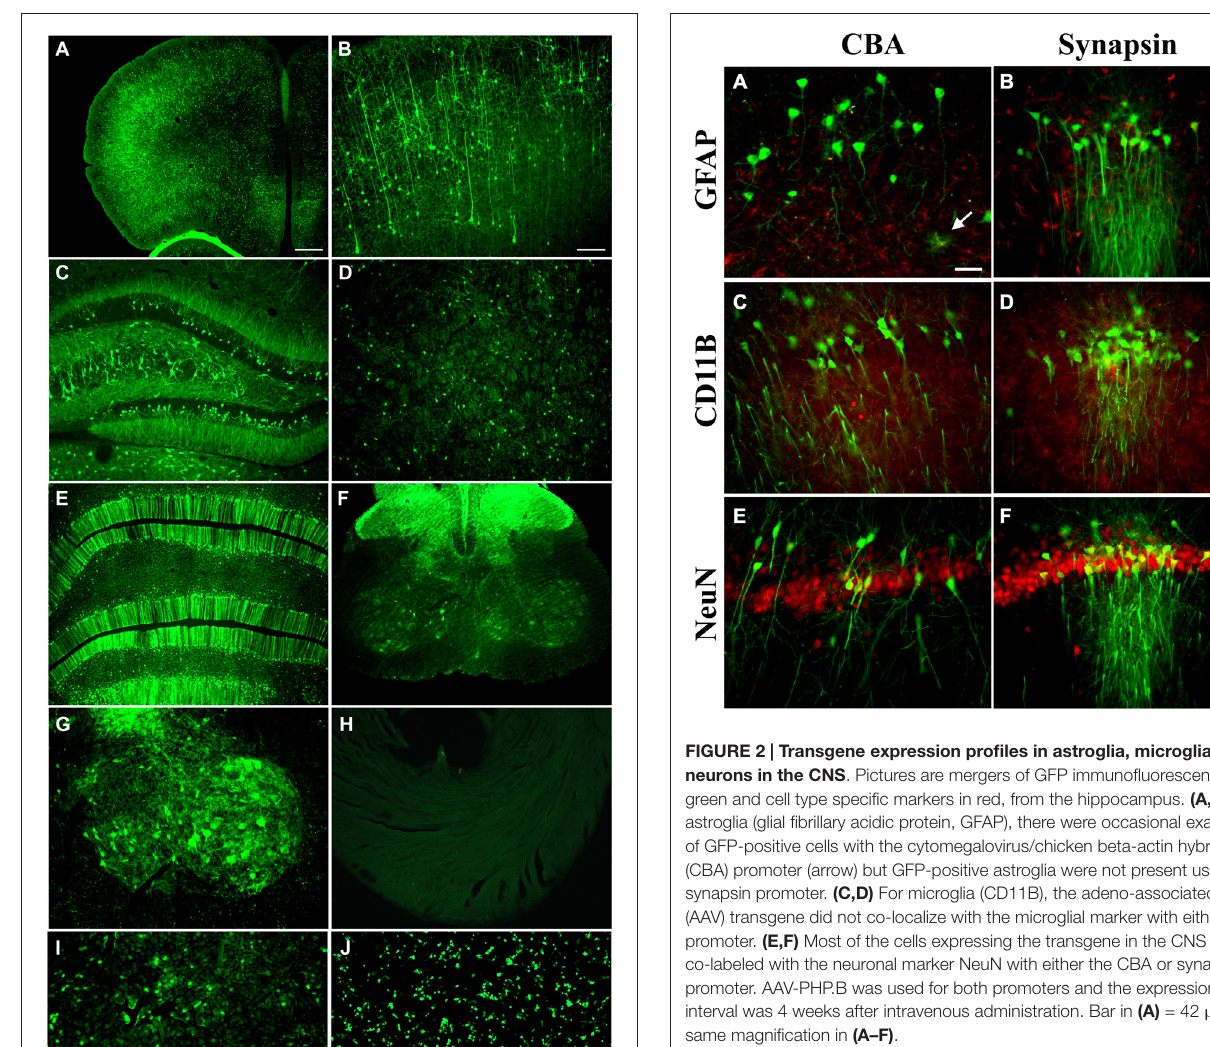
cord among other regions throughout the CNS ( Figures 1A–G ).